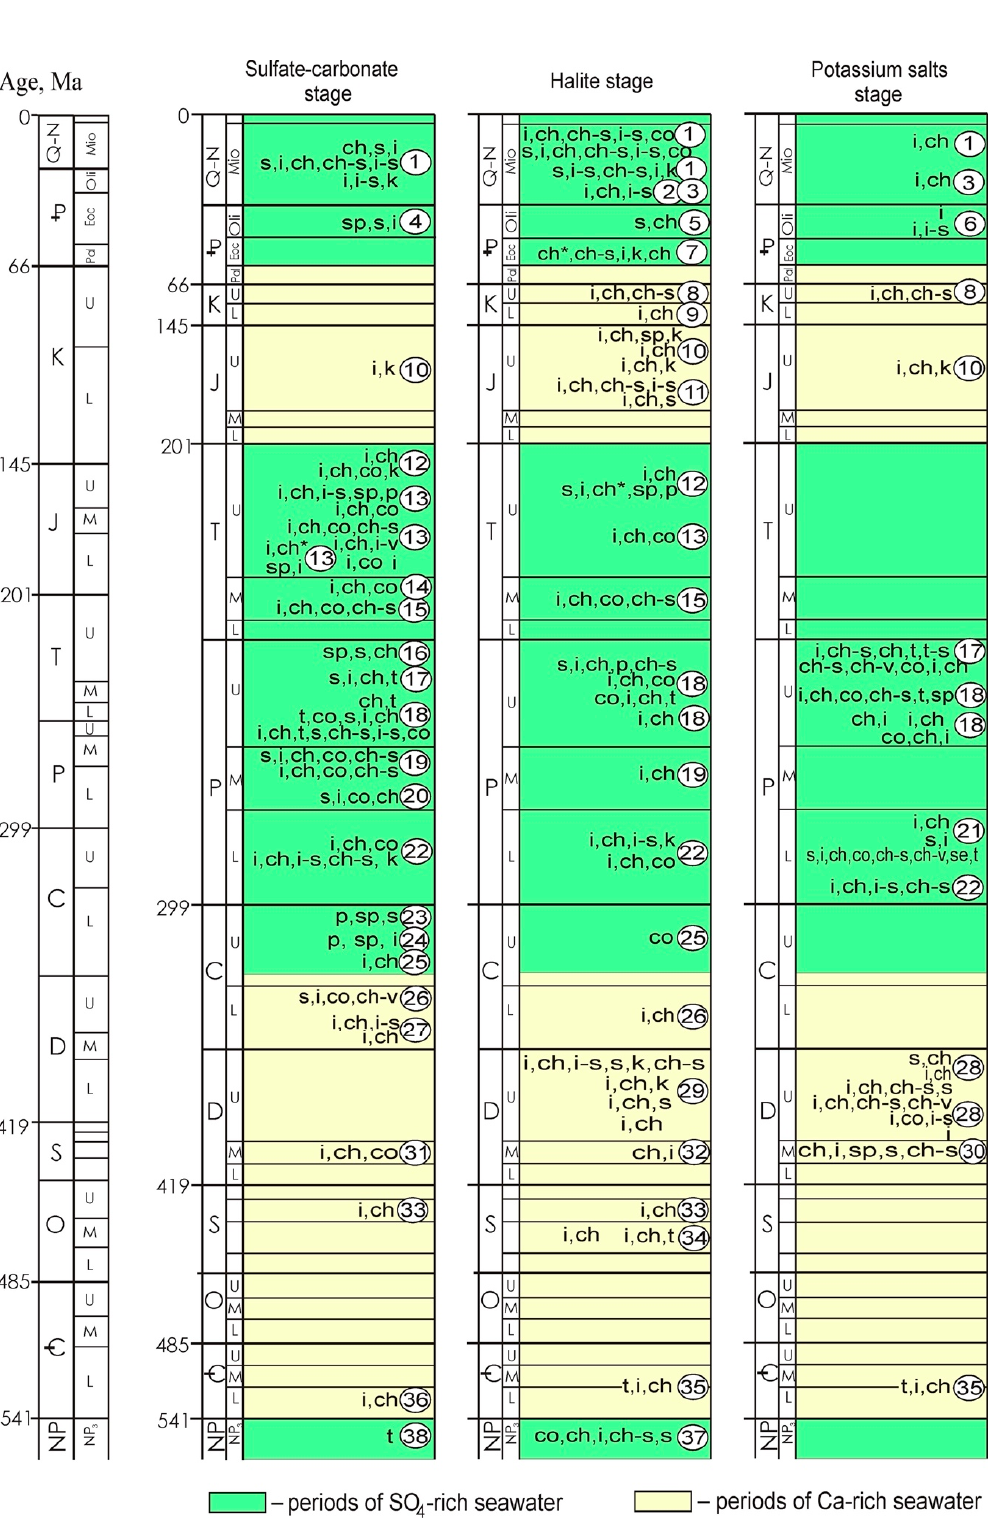
Figure 4. The compositions of clay mineral association of Phanerozoic and Upper Proterozoic evaporite formations deposited from seawater of SO 4 -rich and Ca-rich chemical types. Minerals: ch—chlorite, ch*—swelling chlorite, ch-s—chlorite-smectite, ch-v—chlorite-vermiculite, co—corrensite, hb-v— hydrobiotite-vermiculite, i—illite, i-s—illite-smectite, k—kaolinite, p—palygorskite, s—smectite, se— serpentine, sp—sepiolite, t—talc, t-s—talc-smectite.